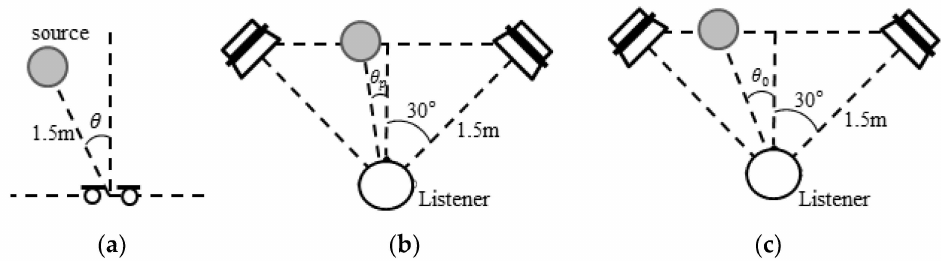
Figure 6. Illustrations of stereophonic image enhancement: ( a ) Original sound source; ( b ) perceived sound source without any enhancement technique; and ( c ) perceived sound source after applying the proposed